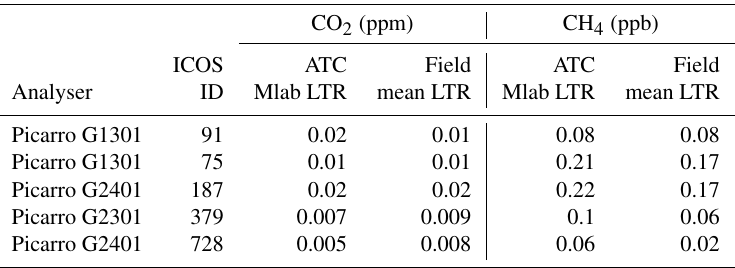
Table 6. Long-term repeatability (LTR) of CO 2 (ppm) and CH 4 (ppb) estimated by MLab and field mean over 2011–2018. Instrument model and ICOS identifier are indicated in the first